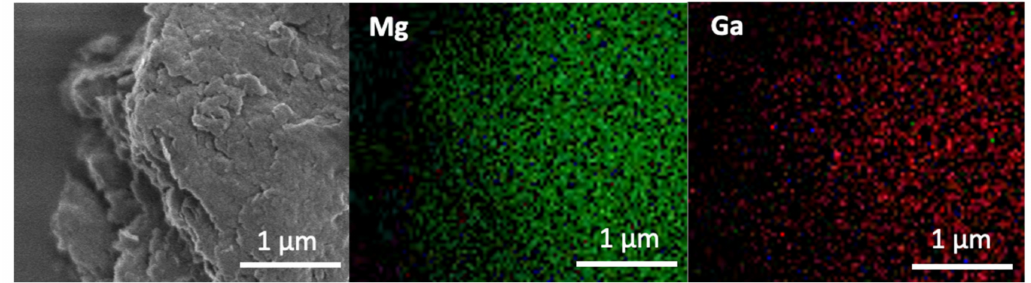
Figure 4. SEM image and elemental mapping of MgGa(I)-0.06. The element was presented by Mg (green) and Ga (red). The area per charge (and the layer charge density) of MgGa(I)-0.24, MgGa(I)-0.11